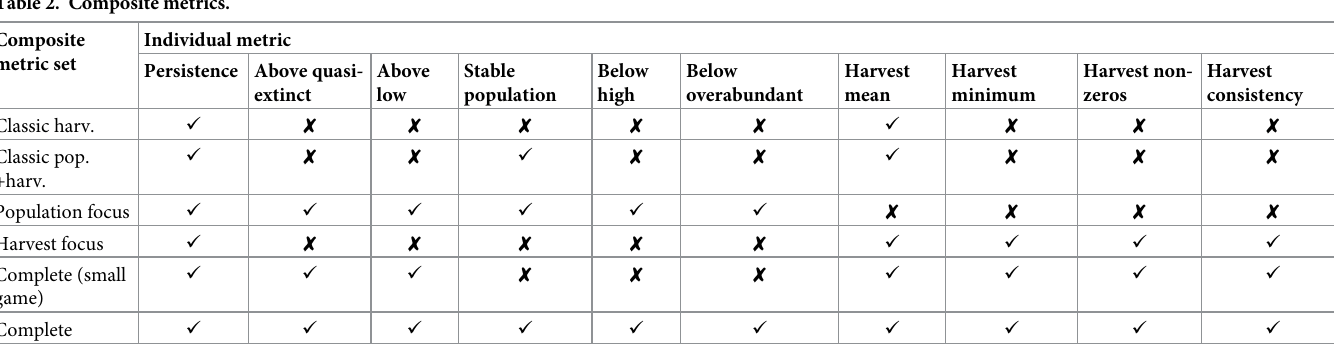
Table 2. Composite